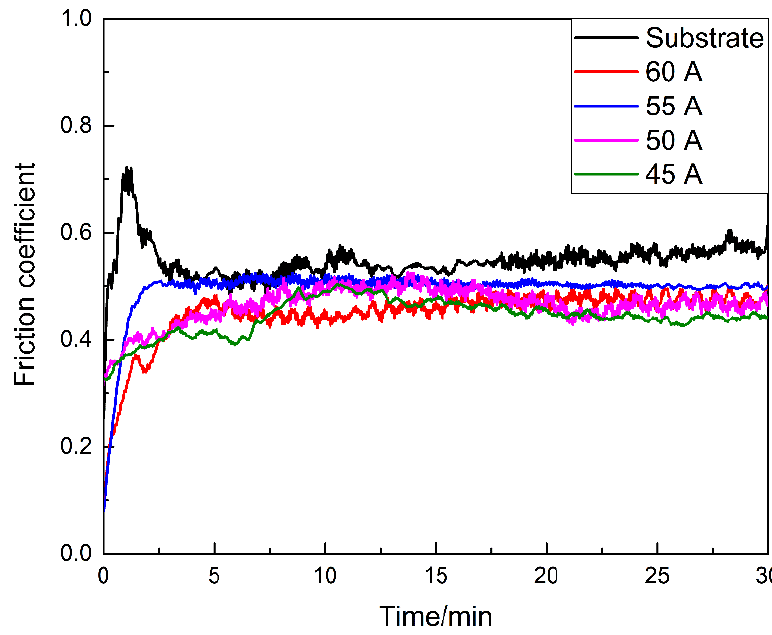
Figure 10. Frictional coefficient of the iron-based coatings and the CGI substrate. Table 5. Statistic frictional coefficients of the iron-based coatings and the CGI substrate. Type 45 A 50 A 55 A 60 A Substrate Friction coefficient 0.46 ±